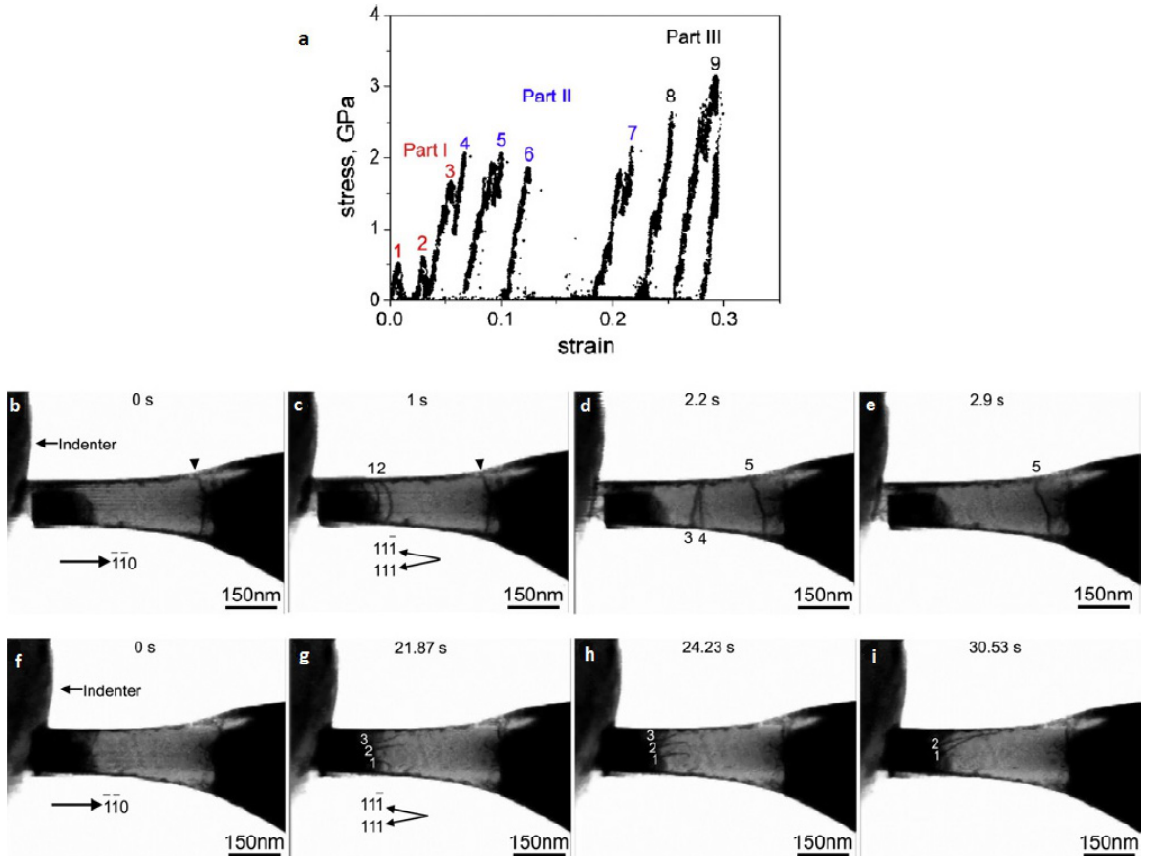
Fig. 28. (a) resulted stress–strain curve of Fe–3% Si single crystal pillar compression, the numbers indi- cate the pop-in events and the curve is divided into three parts. (b-e) Snapshots of the No. 6 pop-in event that occurred in part II; (b) The moment before the pop-in event. A temporarily sessile edge dislocation remained at the bottom of the sample; (c) dislocations 1 and 2 formed at 1 s and escaped the pillar within= 0.03 s; (d) another set of dislocations (3–5) formed at 2.2 s; (e) dislocations 3 and 4 escaped the pillar. (f- i) Snapshots of the No. 9 pop-in event that occurred in part III; (f) The moment before the pop-in event. (g-i) The dislocations moved from the lower pillar rim toward the upper pillar rim. Reprinted with permission from Zhang L, Ohmura T, Sekido K, Hara T, Nakajima K, Tsuzaki K. 2012. Dislocation character transition